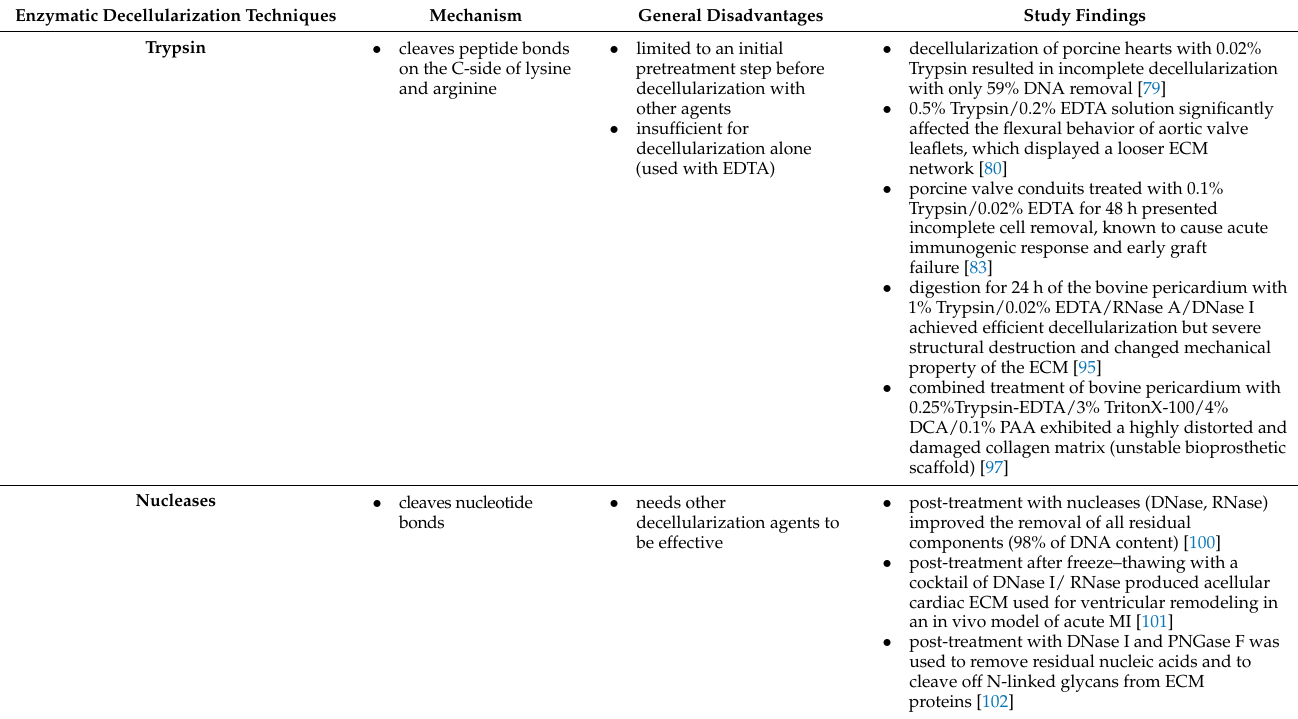
Table 3. Different enzymatic methods used for cardiac tissue decellularization. Enzymatic Decellularization Techniques Mechanism General